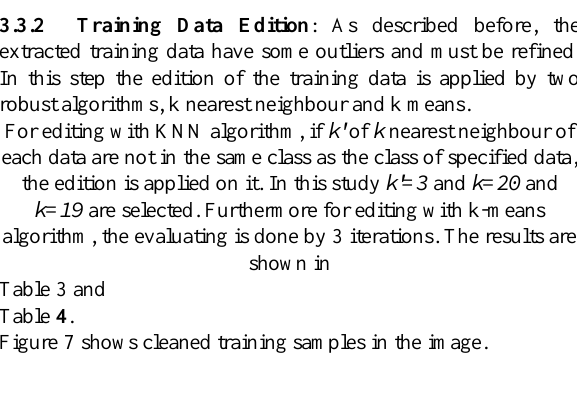
Table 3. Overall accuracies for classification trained with training data that are edited with KNN algorithm